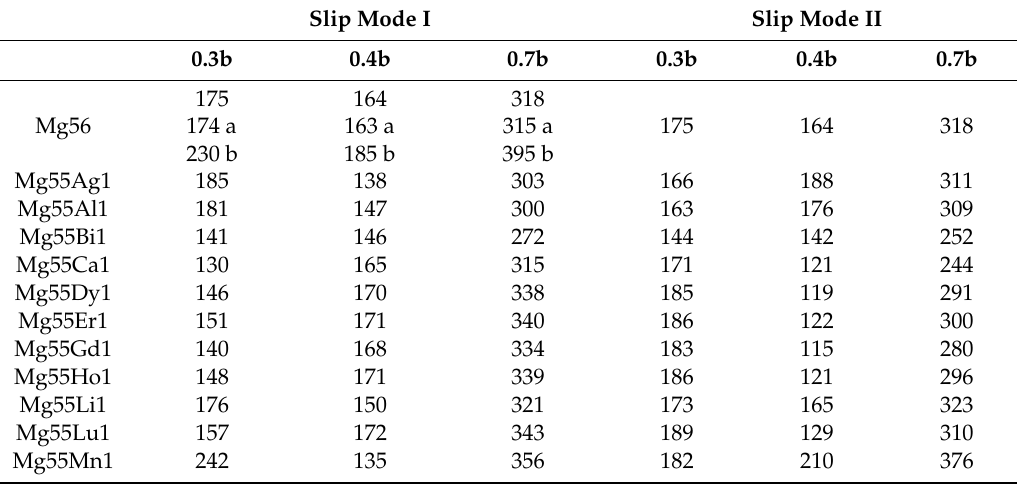
Figure 2. Calculated {10-11} < 11-23 > generalized stacking fault energies (GSFEs) for pure magnesium and Mg55Y1. For pure magnesium, slip mode I is equal to slip mode II. However, substituting a solute atom into the magnesium matrix will cause different effects on these two slip modes. Taking Mg55Y1 as an example, under slip mode I, the stable SFE has disappeared. Table 1. The calculated GSFEs (mJ m − 2 ) for pure Mg and Mg55X1 systems. For pure Mg, GSFE0.4b is stable (where b is the Burgers vector 1 / 3 < 11-23 > ). If the value of GSFE0.4b is bigger than GSFE0.3b, GSFE0.4b is not a local minimum (stable point) anymore, as shown in Figure 2.